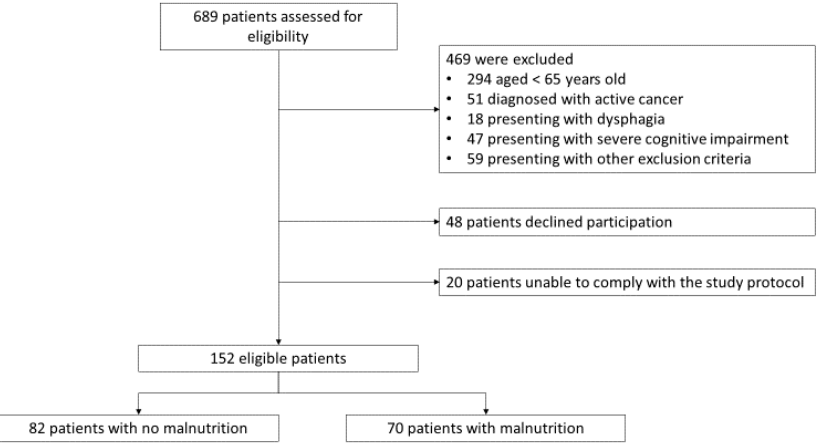
Figure 1. Participant flowchart. Other exclusion criteria were chronic bedridden conditions, physical handicap, severe neuromuscular disease, and use of drugs a ff ecting body composition (such as glucocorticoids, statins, active vitamin D metabolites, anabolic steroids, selective estrogen receptor modulators). Diagnosis of malnutrition was performed according to the new criteria of the Global Leadership Initiative on